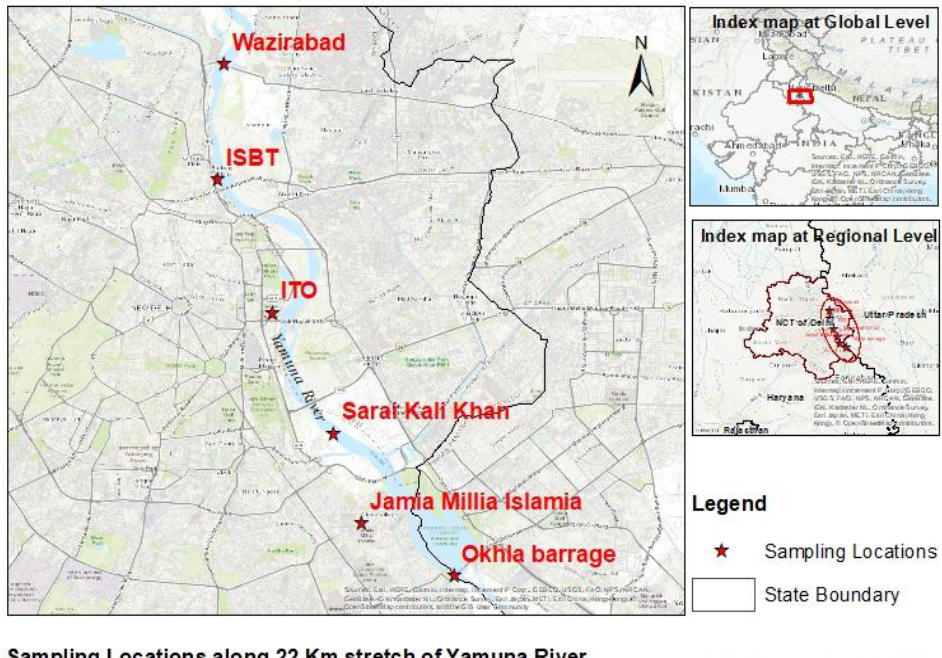
Figure 1. Sampling locations of surface water of the River Yamuna.